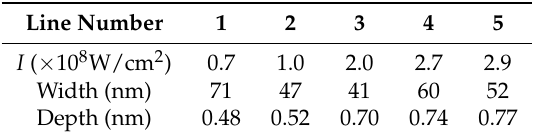
Figure 6. Nanolithography depending on the laser intensity. Gold on glass (30 nm thickness ( a ) after laser irradiation at five lines (slow axis scanning from left to right stopped). Laser intensity I = 0.7 (line 1), 1.0 (line 2), 2.0 (line 3), 2.7 (line 4) and 2.9 × 10 8 W/cm 2 , scanning speed 0.38 µ m/s, angle of incidence θ = 88 ◦ ; ( b ) line profile obtained after taking an average of 256 horizontal profile lines. Widths and depths are indicated in Table 2. Table 2. Laser intensity effect on width (FWHM) and depth of lines in Figure 6b (from left to right). Data are averaged from 256 profile lines.